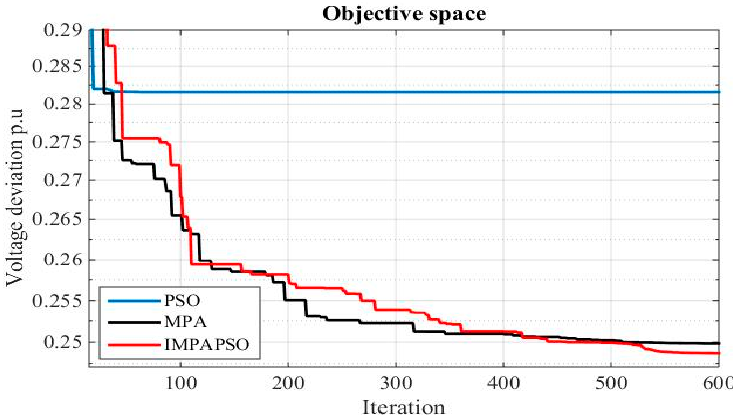
Figure 4. Convergence of PSO, MPA, and IMPAPSO in the second case of the IEEE 30-bus system.